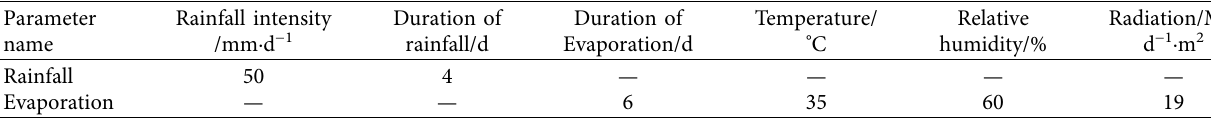
Table 3: Climate parameters.